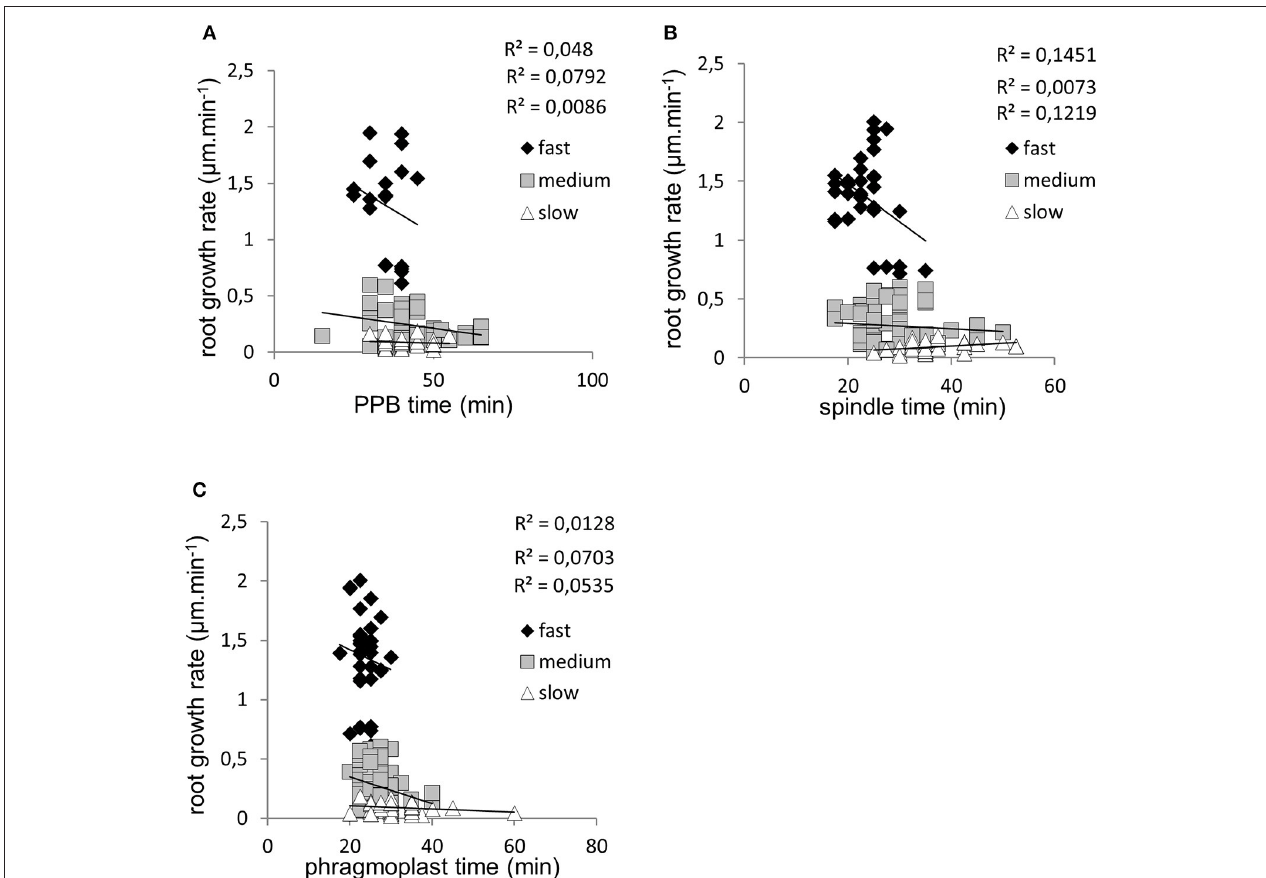
FIGURE 7 | Correlations between root growth rate and duration time of the PPB stage, mitotic spindle stage and phragmoplast stage of dividing cells. (A) Distribution of clusters, correlation lines and correlation coefficients for duration time of the PPB stage in all recorded dividing cells of fast-growing ( (cid:7) ), medium-growing ( (cid:3) ), and slow-growing ( 1 ) roots according to root growth rate. (B) Distribution of clusters, correlation lines and correlation coefficients for duration time of the mitotic spindle stage in all recorded dividing cells of fast-growing ( (cid:7) ), medium-growing ( (cid:3) ) and slow-growing ( 1 ) roots according to root growth rate. (C) Distribution of clusters, correlation lines and correlation coefficients for duration time of the phragmoplast stage in all recorded dividing cells of fast-growing ( (cid:7) ), medium-growing ( (cid:3) ), and slow-growing ( 1 ) roots according to root growth